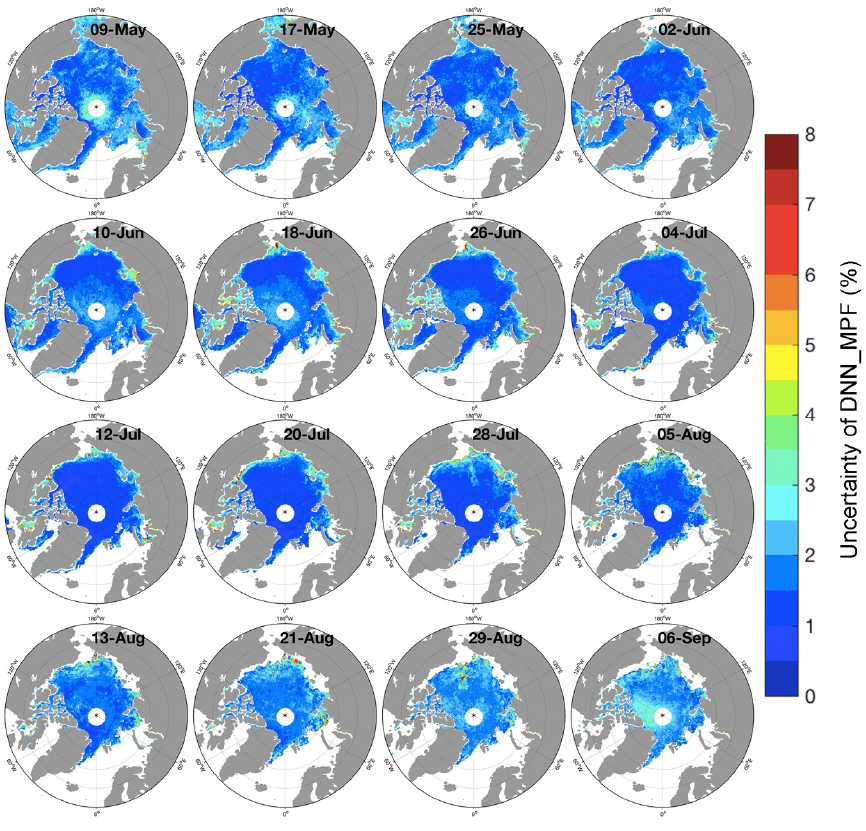
Figure 11. Uncertainties of the DNN_MPF from May to September during 2000–2019.